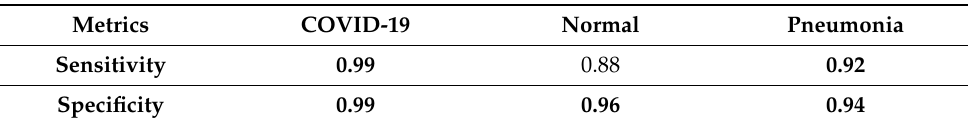
Table 3. Sensitivity and specificity for each infection type for DeepCCXR-Multi (best results high- lighted in bold).